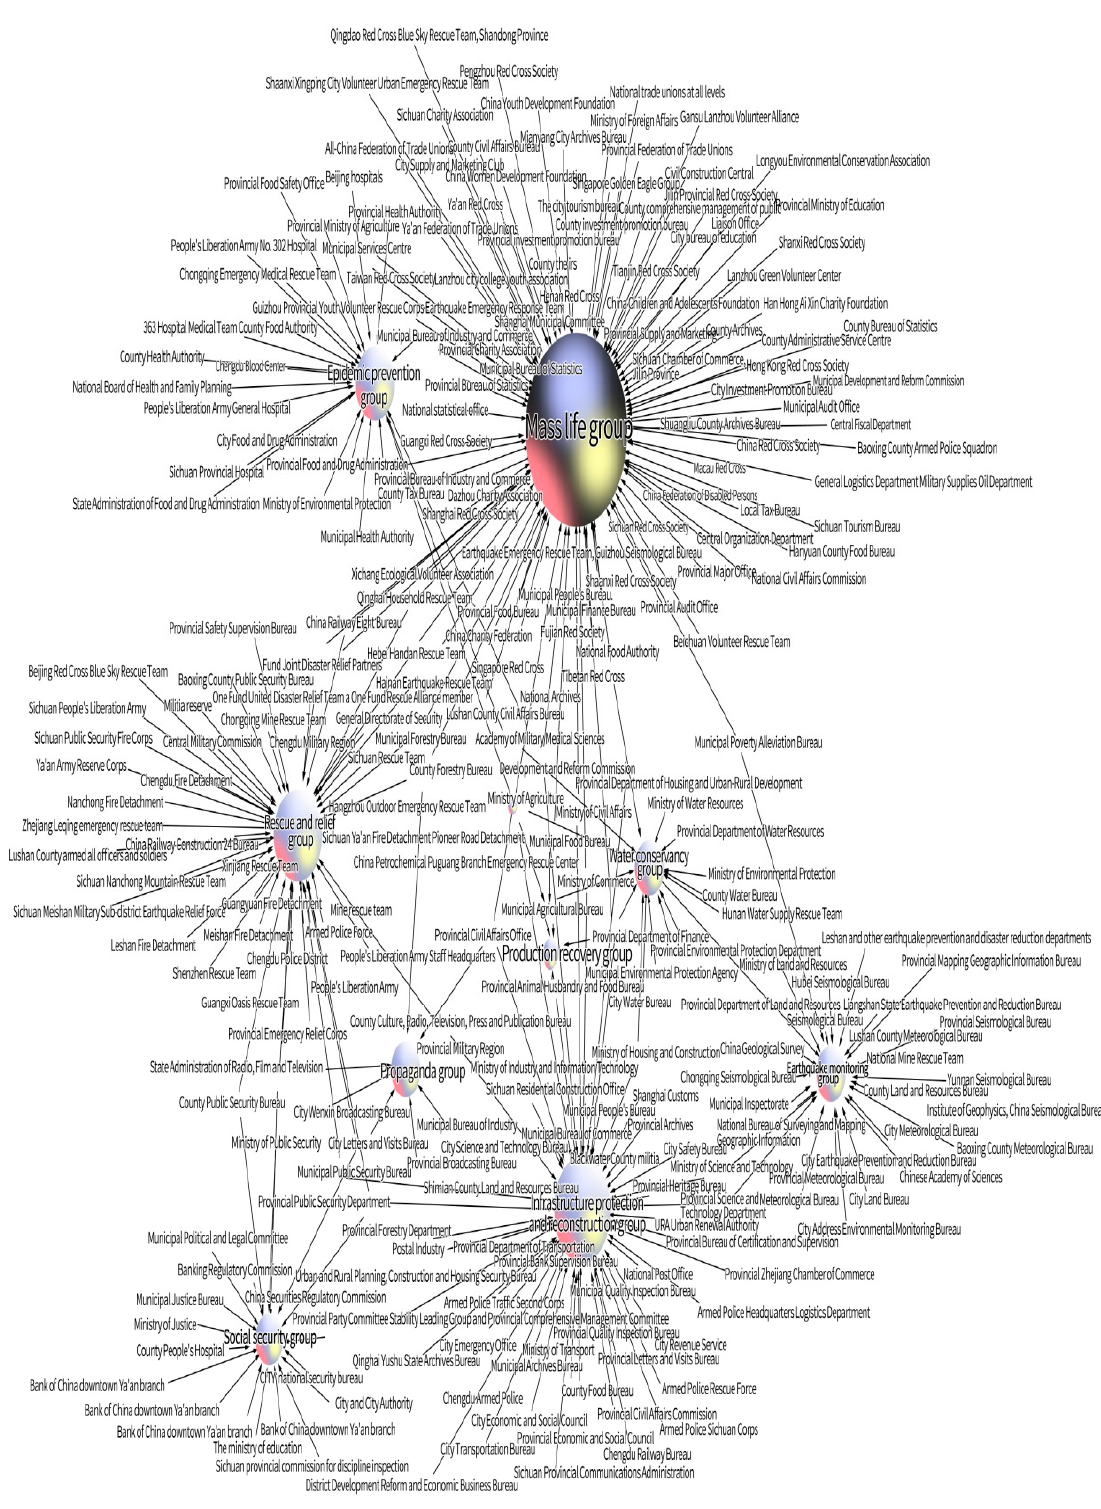
Figure 4. Actual response organization network (due to limited space, the figure is blurry; readers may e-mail the authors for a clearer figure).